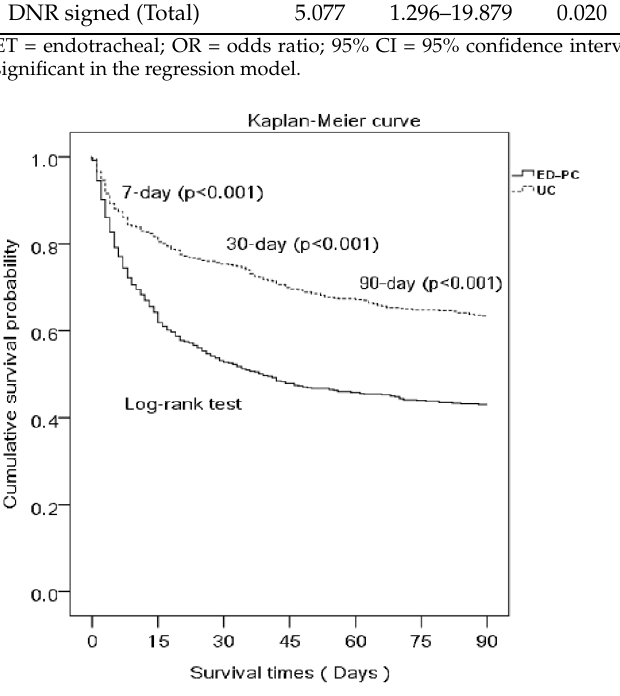
Figure 2. The survival curve of patients with ED-PC and UC.